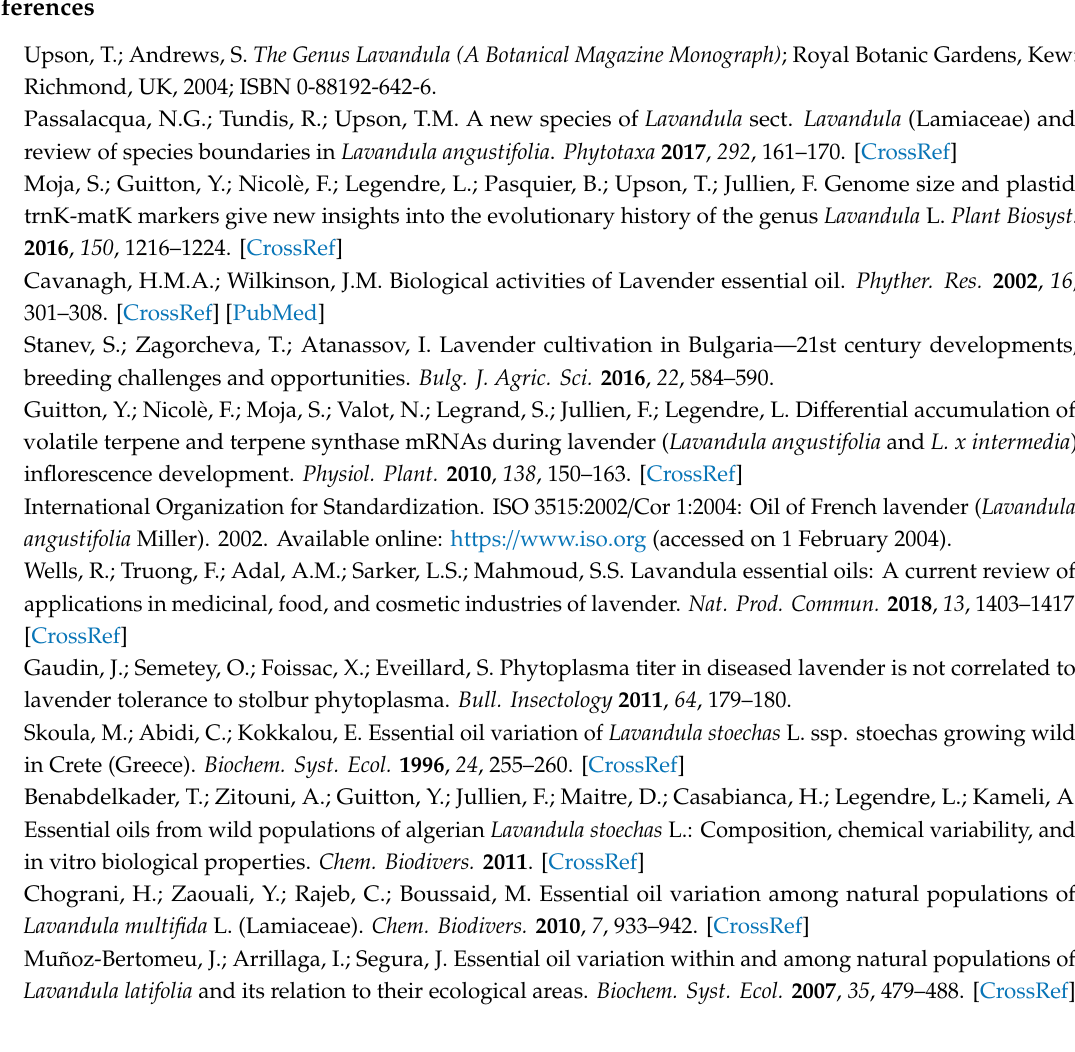
percentage of monoterpenes (% Monoterpene), percentage of sesquiterpenes (% Sesquiterpene) and the mean number of compounds and total relative area (relative area per dry mass unit and relative to the internal standard). For each compound, retention time (RT); retention indices (RI) which are calculated Kovats indices are shown. Figure S1: Map showing the true lavender sites identified during the CNPMAI surveys from 1996 to 2002 (black dots). The sites used in this study are represented with white